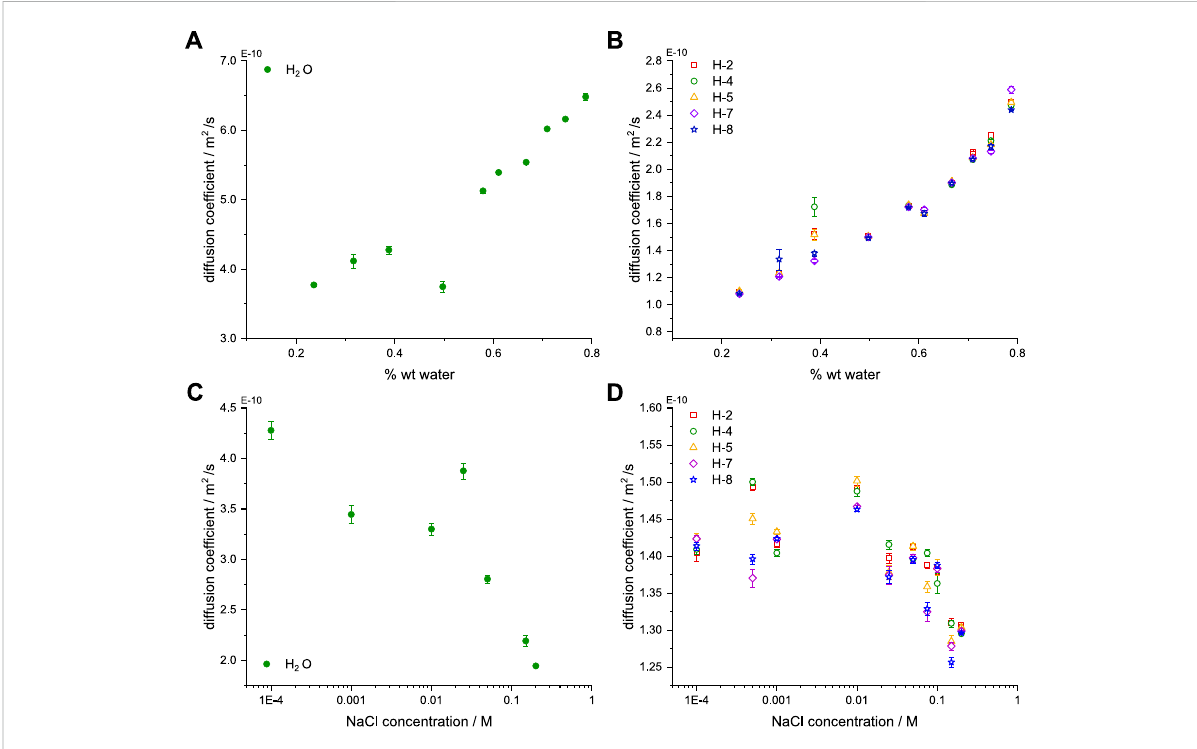
FIGURE 6 Top: Diffusion coef fi cients ( D )of water (A) and EMIM + (B) internary mixtures with constant water:NaCl molecular ratio and shown as afunction of the volumetric water content (% wt water). Bottom: Diffusion coef fi cients of water (C) and EMIM + (D) in ternary mixtures with constant IL:water molecular ratio and shown as a function of theNaCl concentration (M). All presented D correspond to ternary solutions within 1 h from initial mixing of compounds. The time-resolved stability of solutions containing selected IL:water:NaCl molecular ratios is presented in Supplementary Figures S16 –